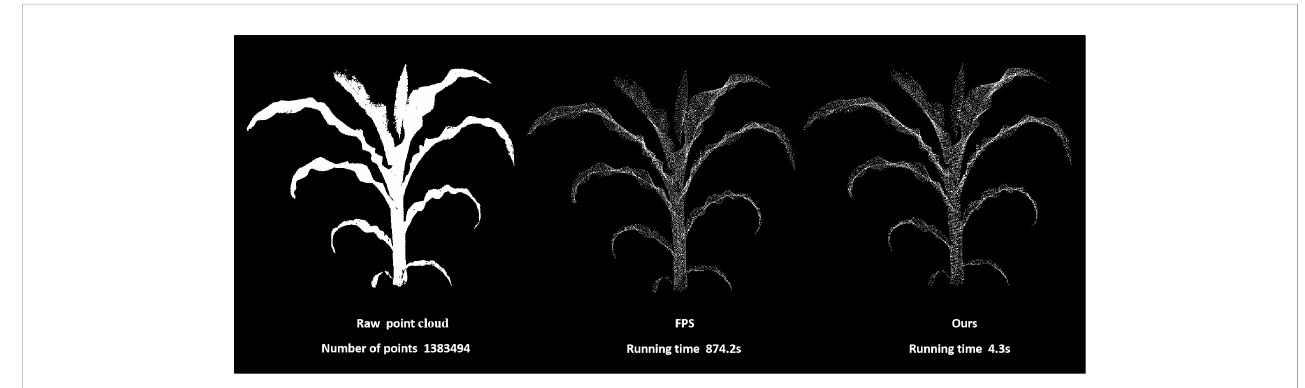
FIGURE 2 A comparison plot of plant point cloud down-sampling methods.